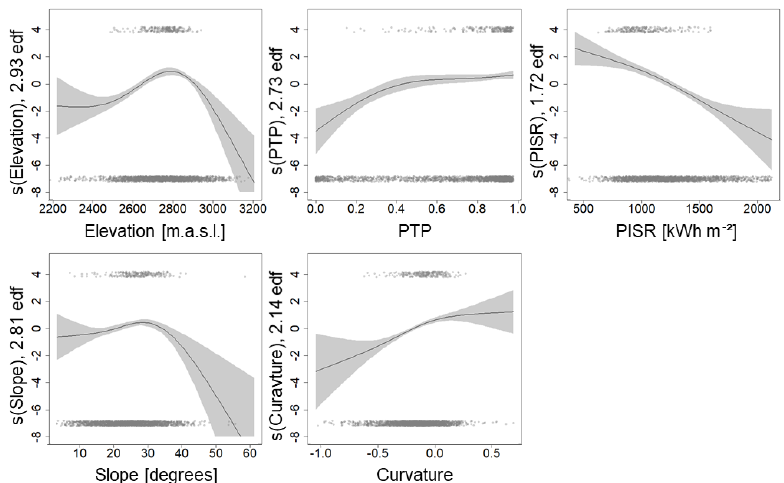
Figure 7. Transformation function plots of the GAM model showing the relationship between each predictor variable and destabilization occurrence. The data distribution with respect to predictor variables is indicated with dots on top (destabilization evidence) and on the bottom (stability evidence) of the plots. The y axis represents the transformation of the predictor variable by the GAM’s spline, indicated here by “ s (predictor)”. The effective degrees of freedom are also reported. The PTP is presented here for explanatory purposes, although it was not included in the final model.